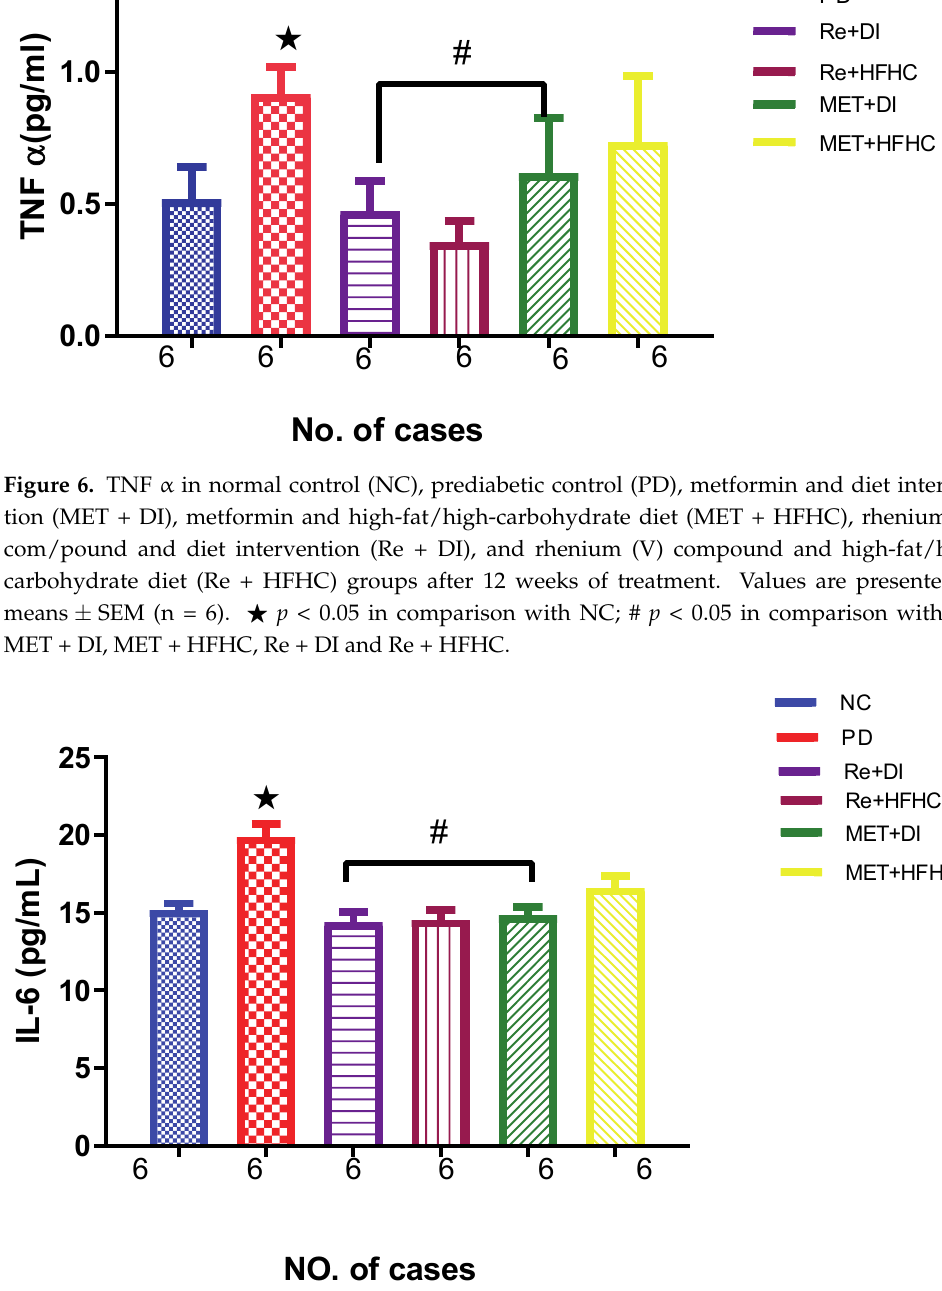
Figure 7. IL-6 concentration in normal control (NC), prediabetic control (PD), metformin and diet intervention (MET + DI), metformin and high-fat/high-carbohydrate diet (MET + HFHC), rhenium (V) compound and diet intervention (Re + DI), and rhenium (V) compound and high-fat/high-carbohydrate diet (Re + HFHC) groups after 12 weeks of treatment. Values are presented as means ± SEM (n = 6). (cid:70) p < 0.05 in comparison with NC; # p < 0.05 in comparison with PD, MET + DI, MET + HFHC, Re + DI and Re + HFHC.